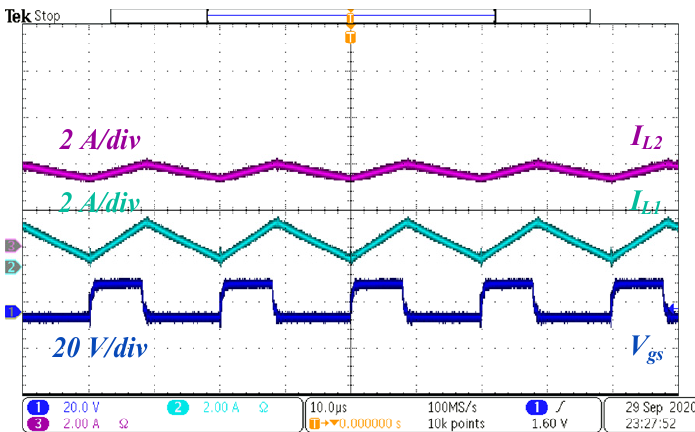
Figure 14. Output voltage at 24 V input and D = 0.4.